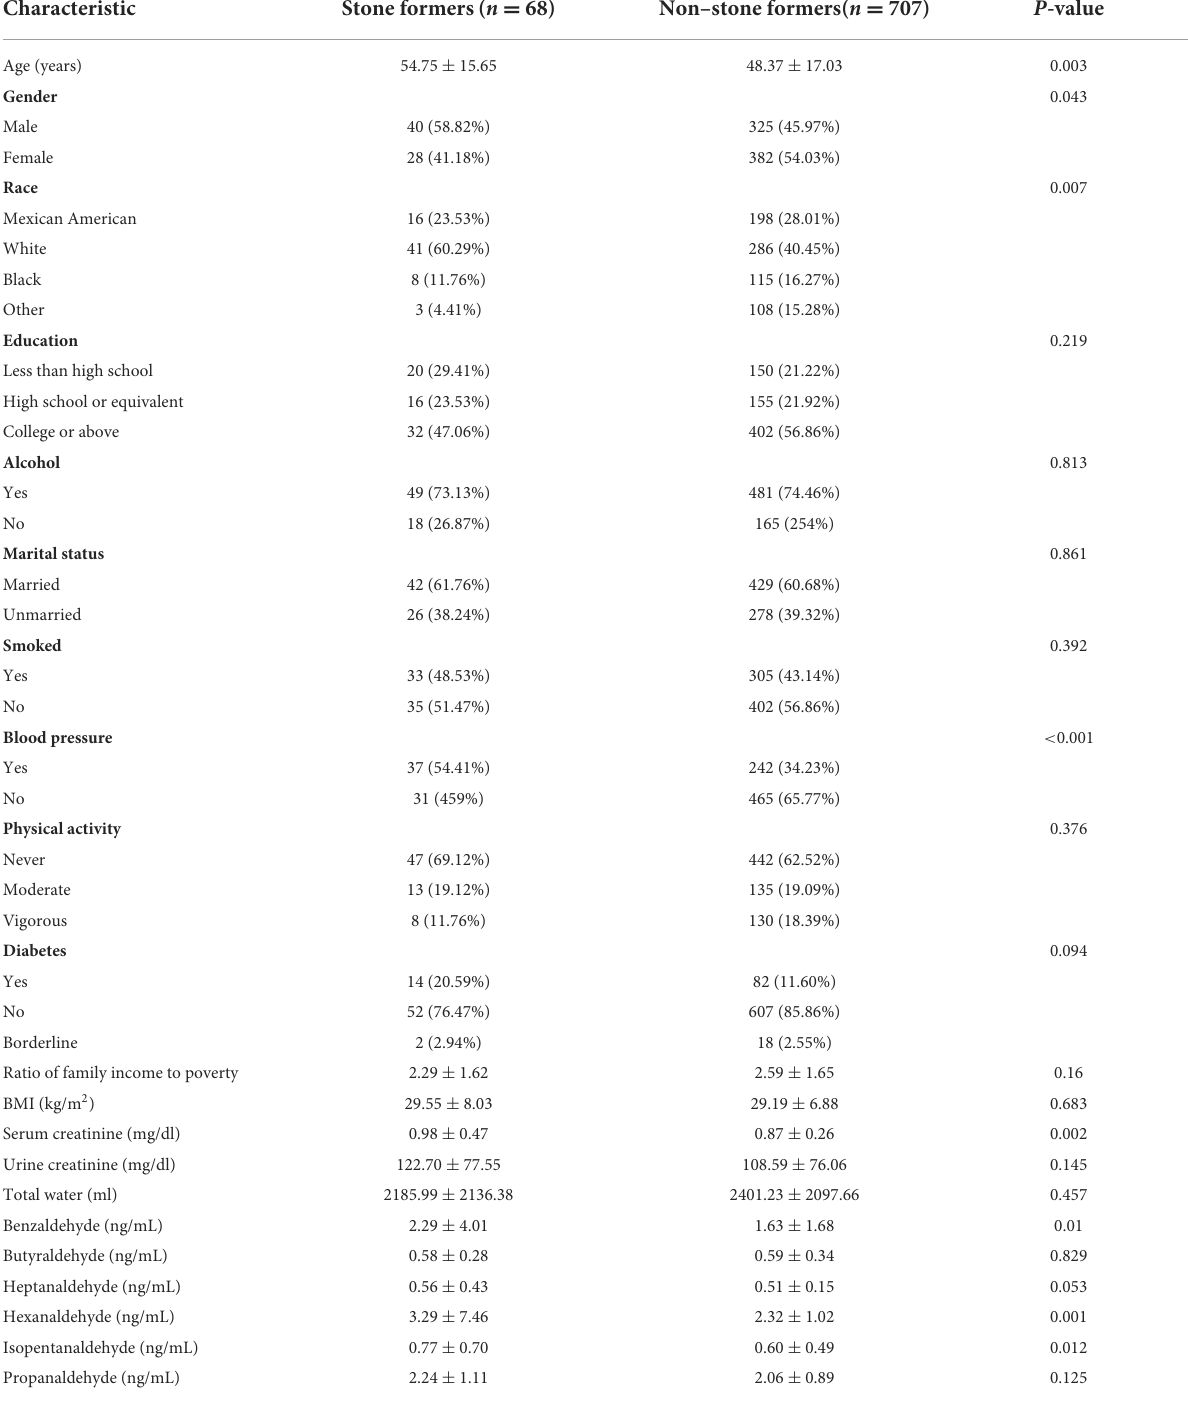
TABLE 1 Baseline characteristics of participants in NHANES from